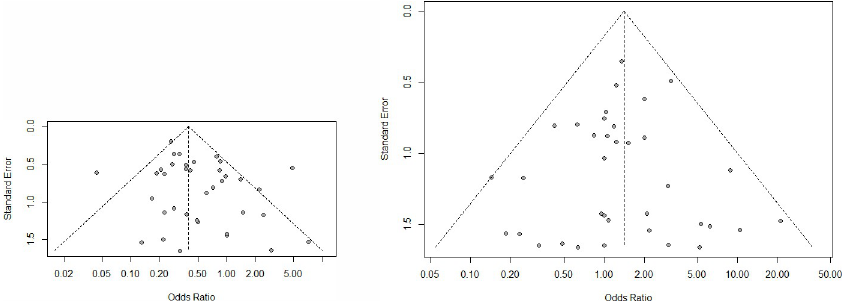
Fig 3. Funnel plot of studies evaluating the publication bias of intraoperative and intraoperative complications between MIS and ORH. (A). intraoperative complications. (B). postoperative complications.